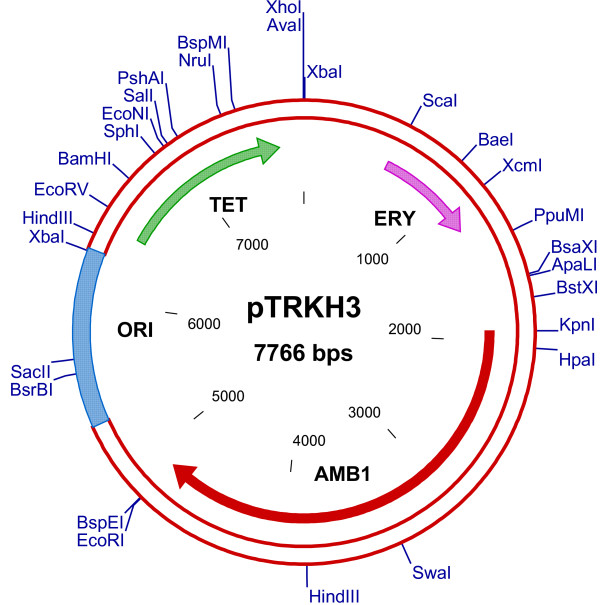
The shuttle vector pTRKH3.